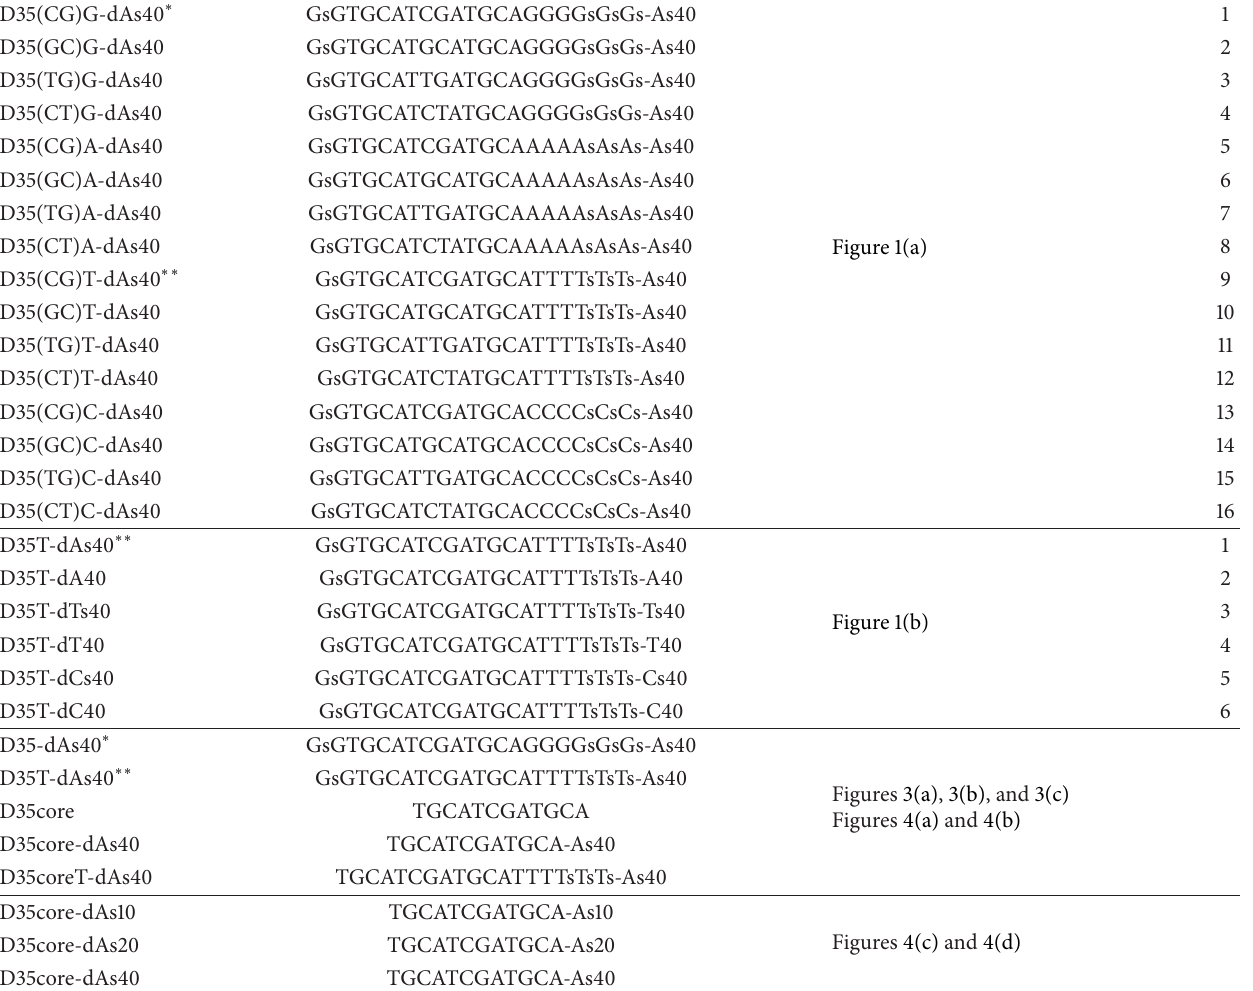
Table 1: Modified D35 ODNs developed in this